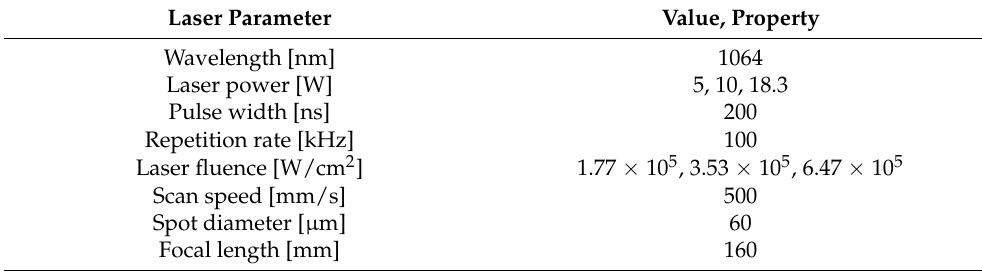
Table 1. Laser processing